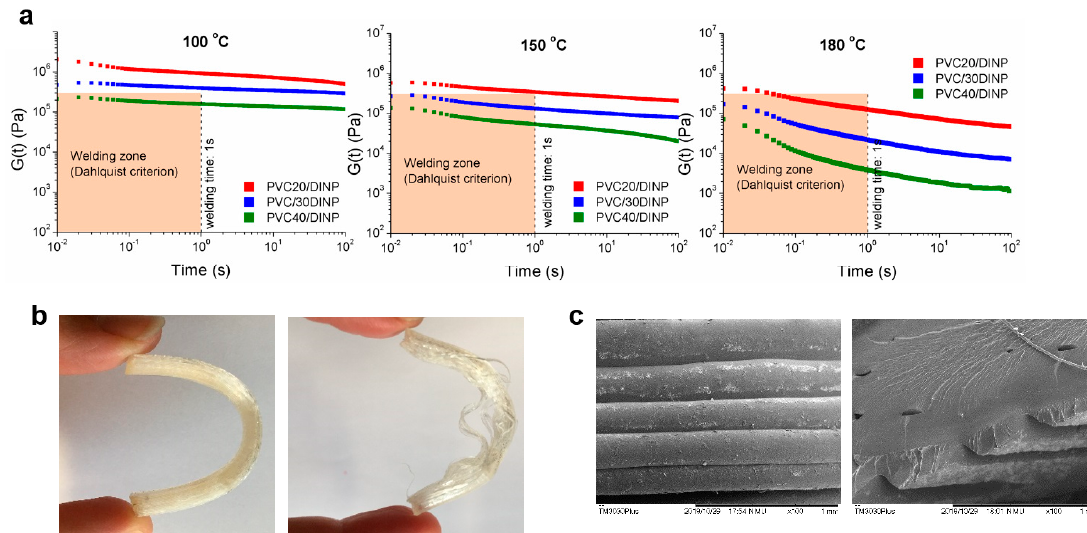
Figure 8. ( a ) Stress relaxation experiments at different temperatures for printable samples, showing welding zone according to Dahlquist criterion (see text). ( b ) Bending test to show good (left) and poor (right) layers adhesion in samples obtained at two different printing temperatures for PVC/40DINP: 210 °C (left) and 190 °C (right). ( c ) SEM micrographs for PVC/40DINP printed at 210 °C.